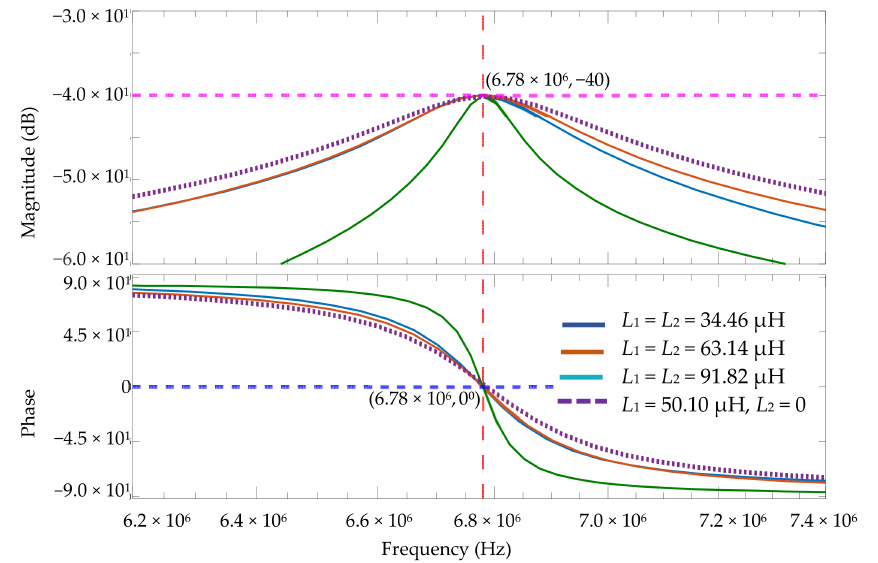
Figure 6. | I 1 / V i | value in magnitude and phase for both symmetrical and asymmetrical